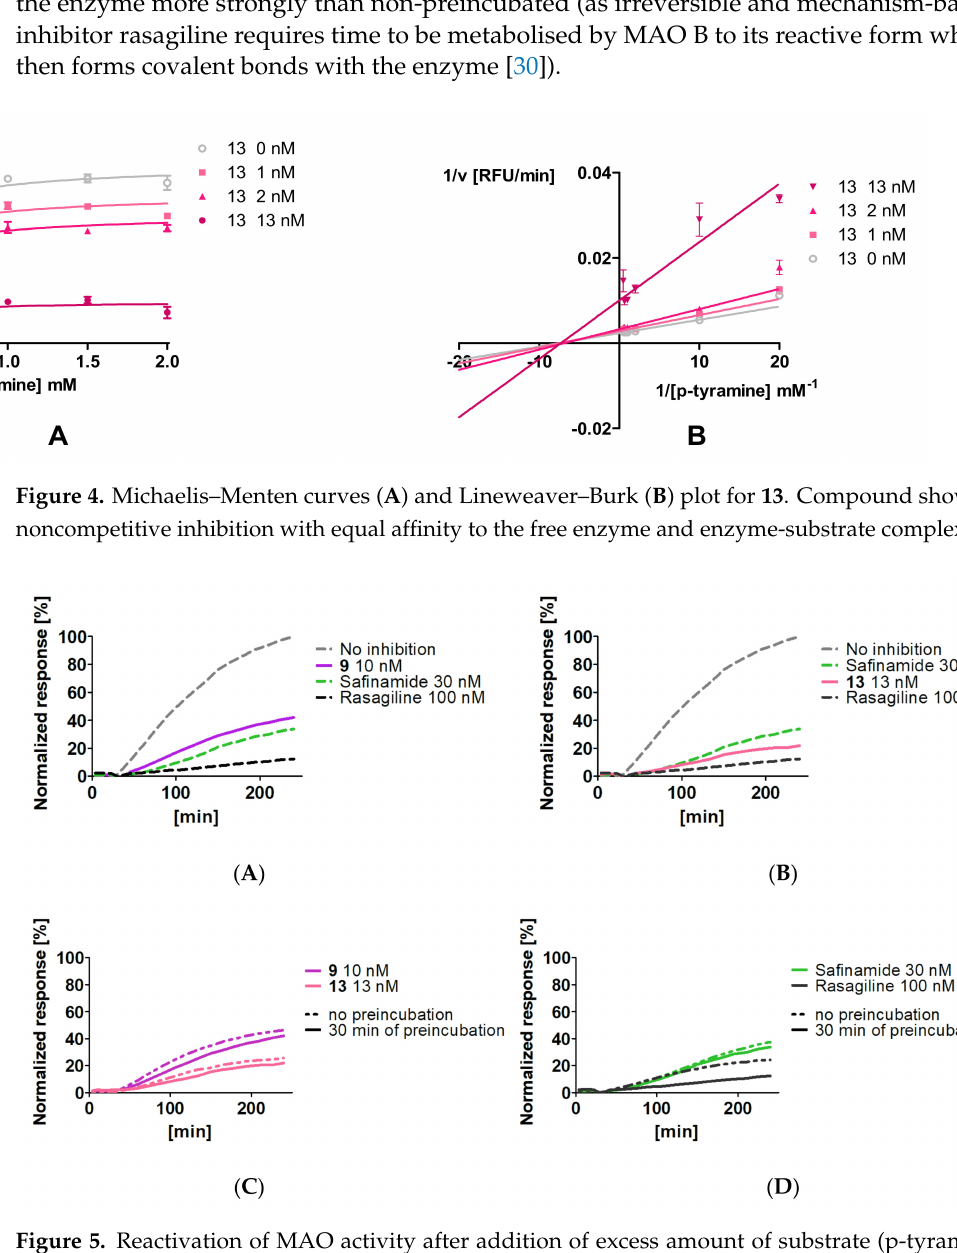
Figure 5. Reactivation of MAO activity after addition of excess amount of substrate (p-tyramine 200 µ M) to the enzyme previously inhibited by irreversible (rasagiline), reversible (safinamide) and tested inhibitors in concentrations corresponding to their IC 80 . Only the variant with preincubation was shown on the chart to not disturb the readability ( A , B ). Comparison of curves from preincubated and non-preincubated variant of experiment: preincubated rasagiline inhibited the enzyme more strongly than non-preincubated, while safinamide, 9 and 13 showed almost no differences between preincubated and non-preincubated samples ( C , D